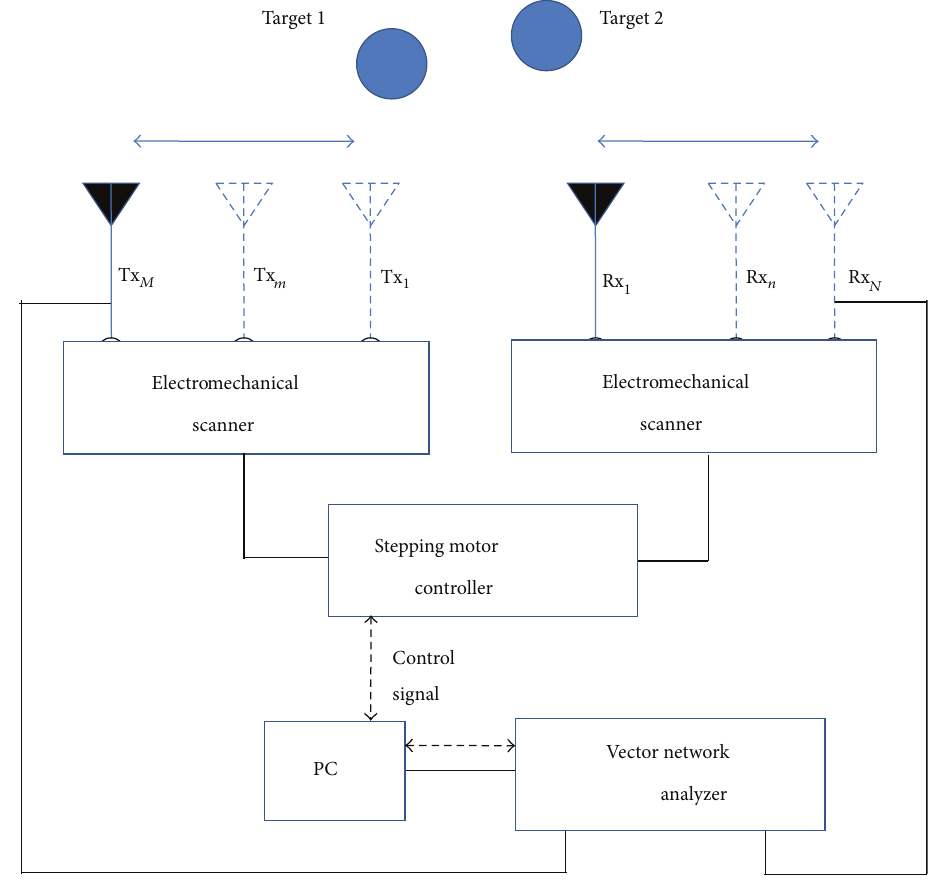
Figure 16: Measurement setup.